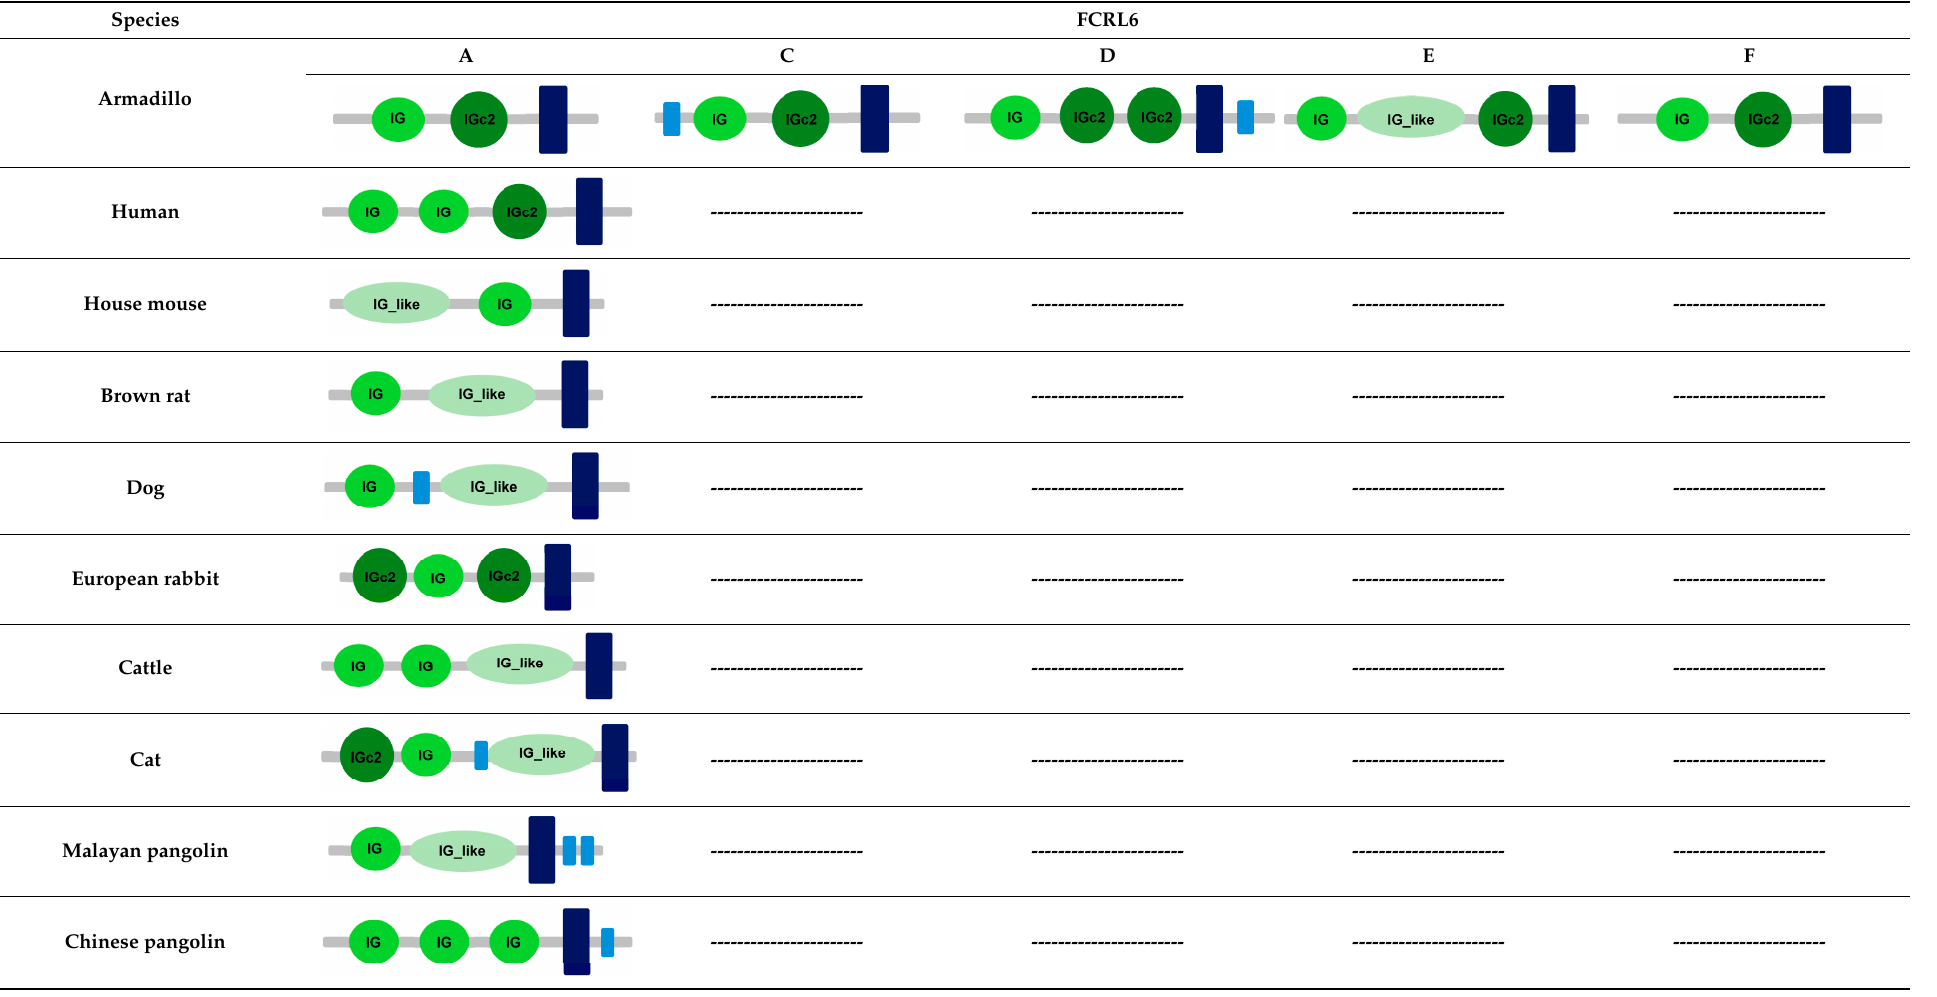
Table 1. Predicted domains, repeats, motifs and features of Fc receptor-like 6 (FCRL6) among a panel of mammalian species (http://smart.embl-heidelberg.de/